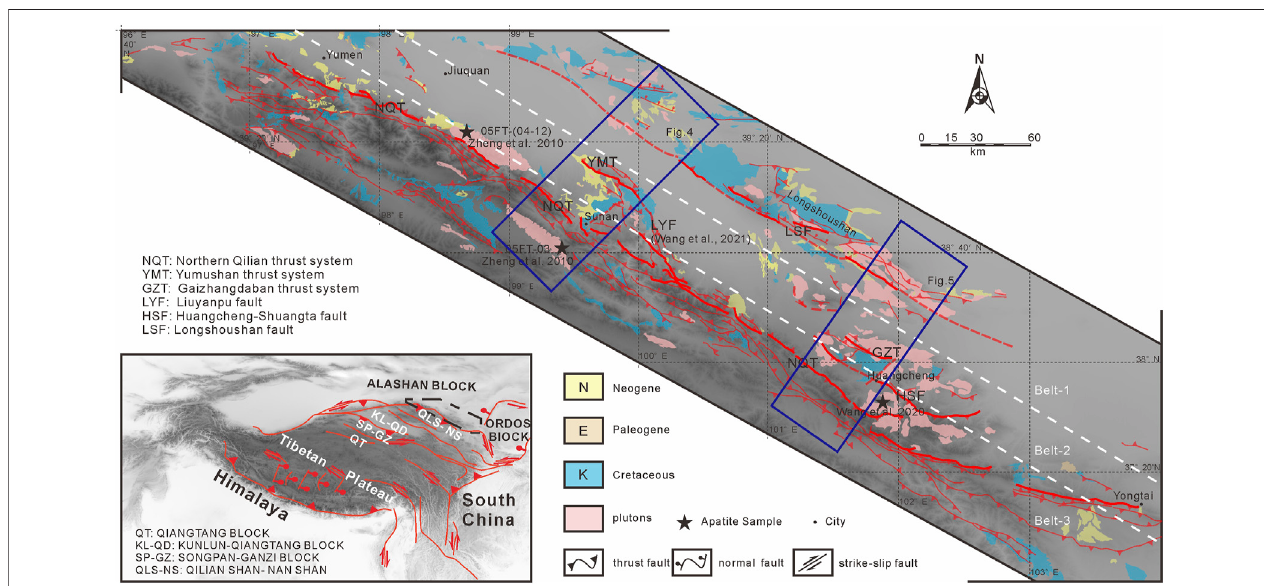
FIGURE 1 | Geologic map of the Qilian Shan – Hexi corridor. Map based on data from the Bureau of Mineral Resources of Gansu Province (BMRGP, Regional GeologicalSurvey)(1982),BMRIMP(1991),BureauofMineralResourcesofQinghaiProvince(BMRQP,RegionalGeologicalSurvey)(1991),and fi eldworkconductedfor this